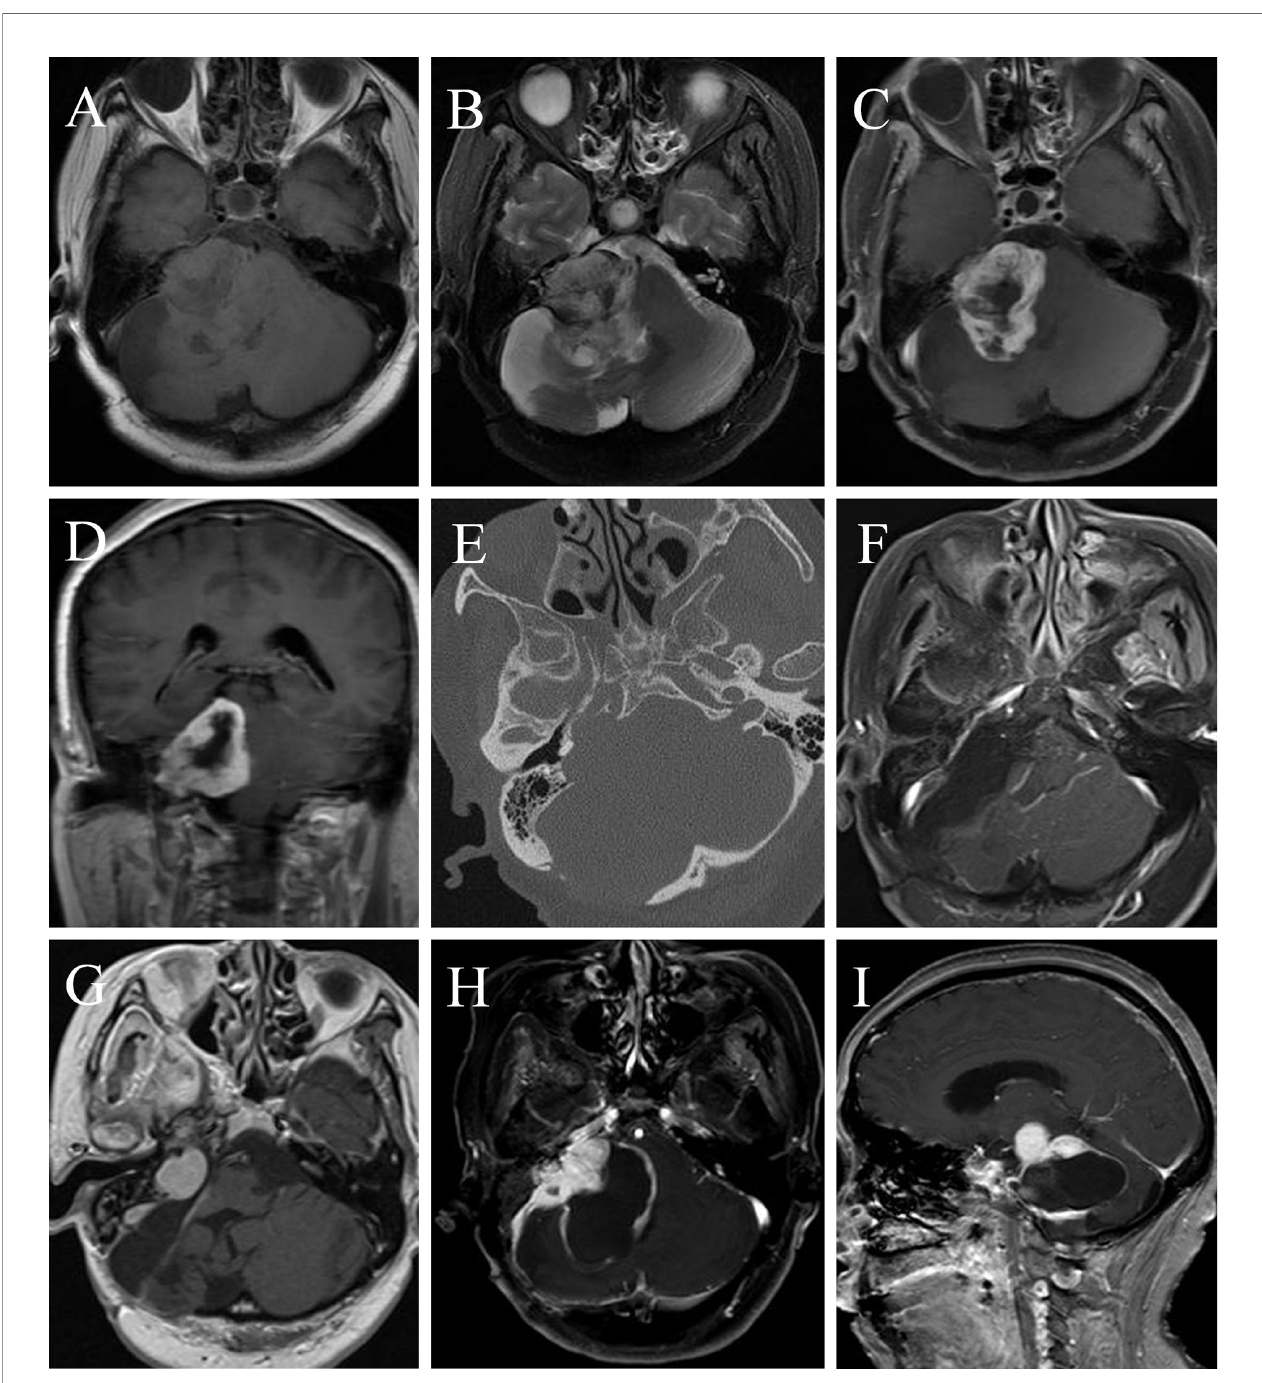
FIGURE 3 | A MTVS with atypical radiological manifestation. Case 1. Magnetic resonance image (MRI) of a 51-year-old female showed a recurrent vestibular schwannoma, which was iso- to hypointense on T1-weighted (A) and heterogenous hyperintense on T2-weighted (B) images, with peritumoral edema. It was heterogeneously enhanced with cystic formation and irregular shape after administration of gadolinium (C, D) . A thin-slice CT scan of the internal auditory canal (E) showed the expansion of the right internal auditory canal and bone resorption destruction. The tumor was totally resected (F) and the histopathologic tests con fi rmed the diagnosis of a typical vestibular schwannoma. Gamma knife radiosurgery was prescribed to the patient 3 months later because of tumor recurrence (G) . One year later, contrast-enhanced MRI depicted a recurrent tumor with unusual manifestation-broad-based cystic-solid tumor with cyst wall enhancement, extending to petrous apex and ambient cistern (H, I) . She underwent the third operation in our department and the pathological diagnosis was MPNST (WHO grade 3/FNCLCC grade 2). Note: part of Figure 3 has been demonstrated on Jiuhong Li ’ s Chinese Master ’ s Thesis.